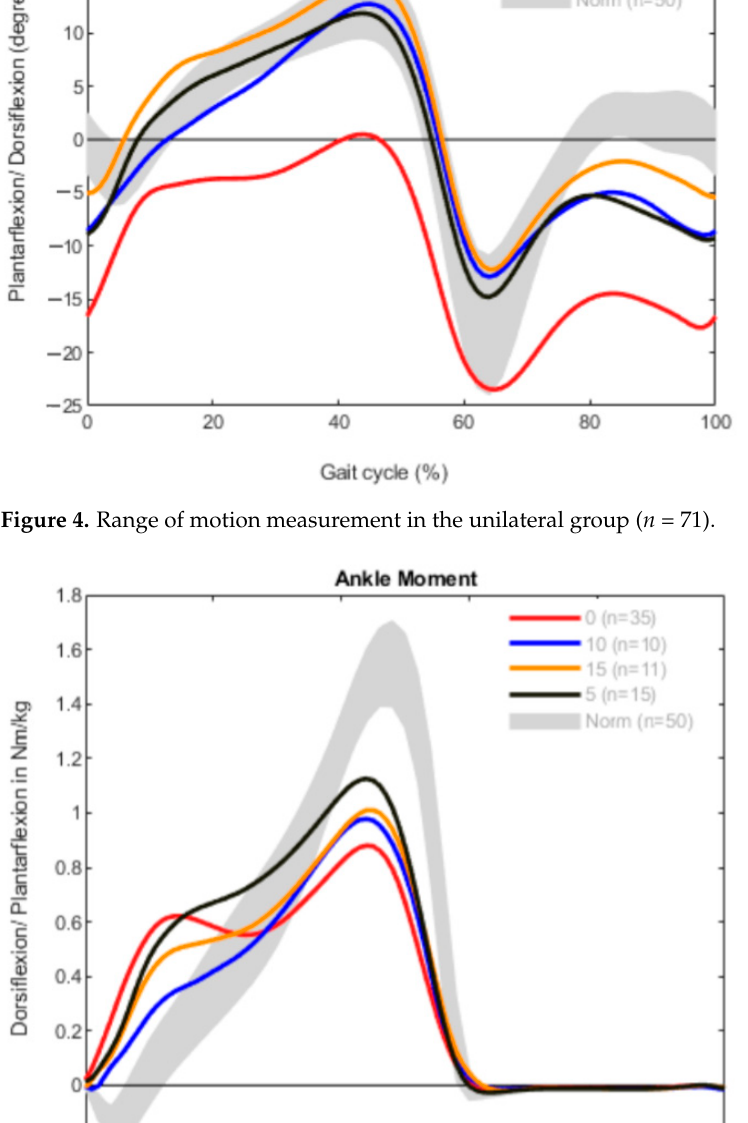
Figure 5. Ankle moment measurement in the unilateral group ( n = 71).